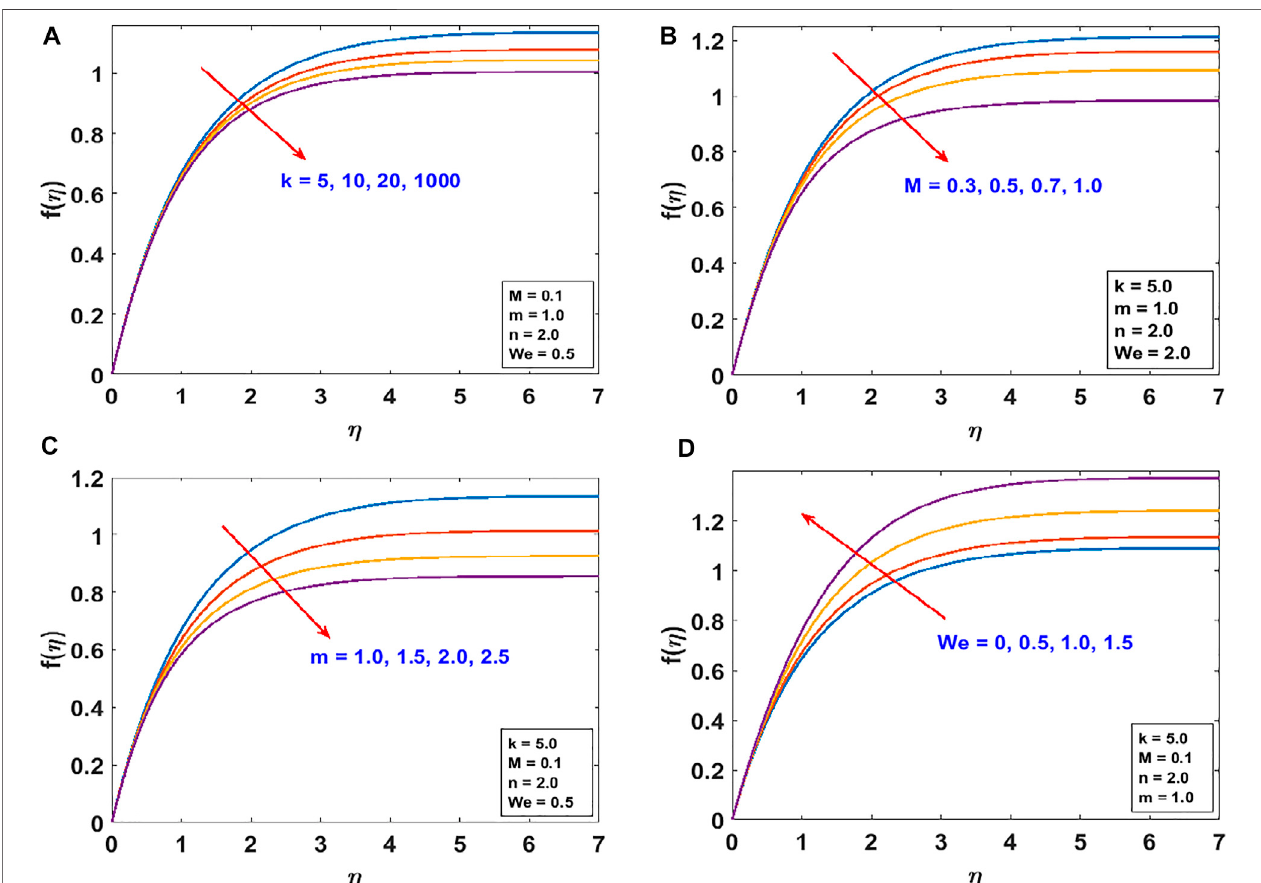
FIGURE 2 | Effect of k, M, m, and We on the stream